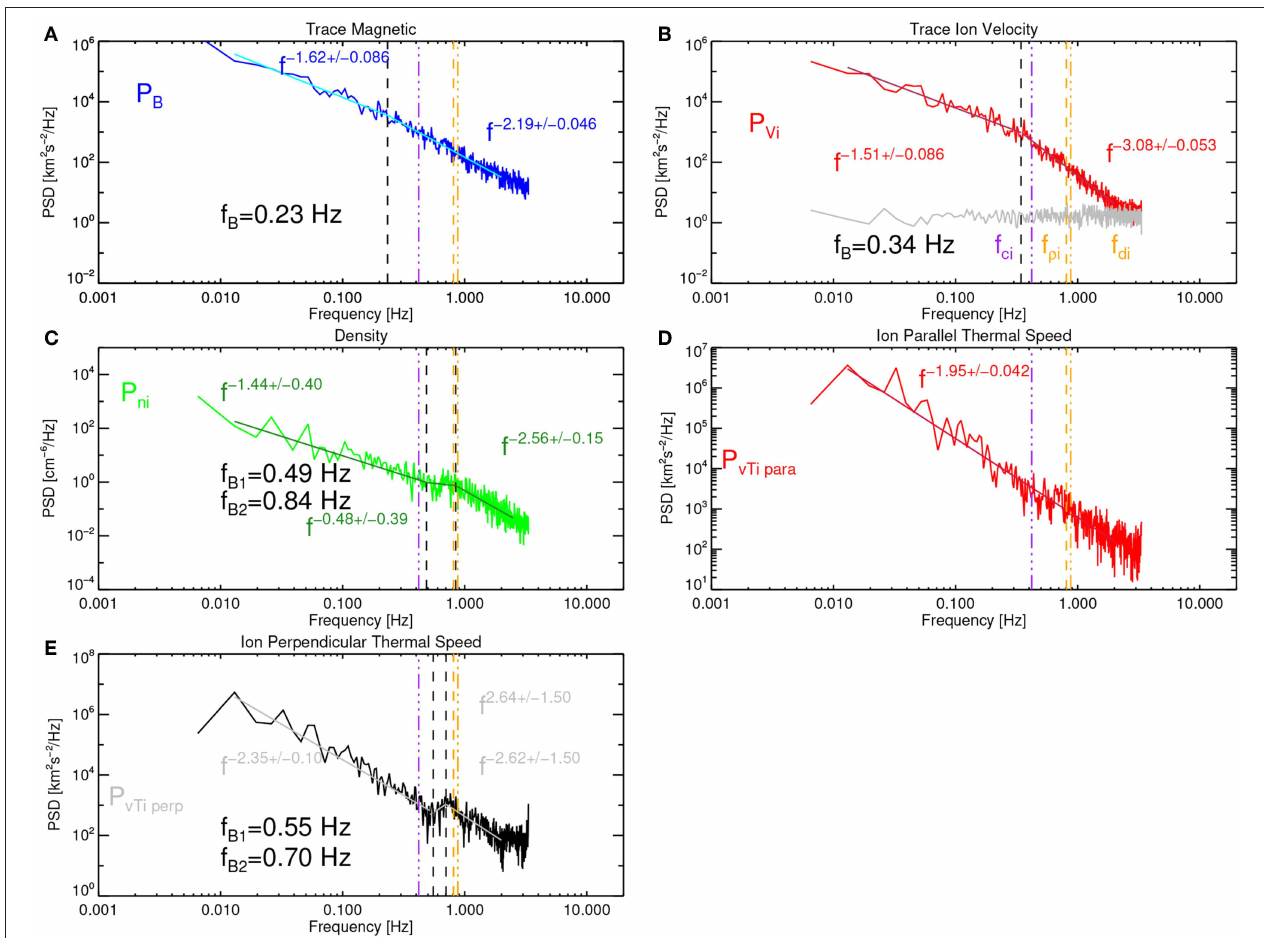
FIGURE 2 | Power spectral densities of measured quantities. (A) shows the trace magnetic field (B) shows the trace ion velocity (red) and the estimated noise floor in gray (C) shows the density (D,E) show the parallel and perpendicular